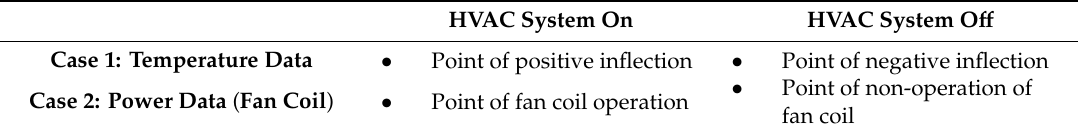
Table 7. HVAC System Scheduling Point Based on Inferred